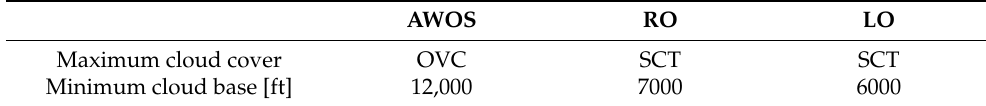
Table 4. Determination of the maximum cloud cover and the lowest cloud base height using three different approaches at LZTT, on 11 September 2018, at 09:20 UTC. AWOS—Automated Weather Ob- servation System, RO—Remote observer, LO—Local observer, OVC—overcast, and SCT—scattered. AWOS Maximum cloud